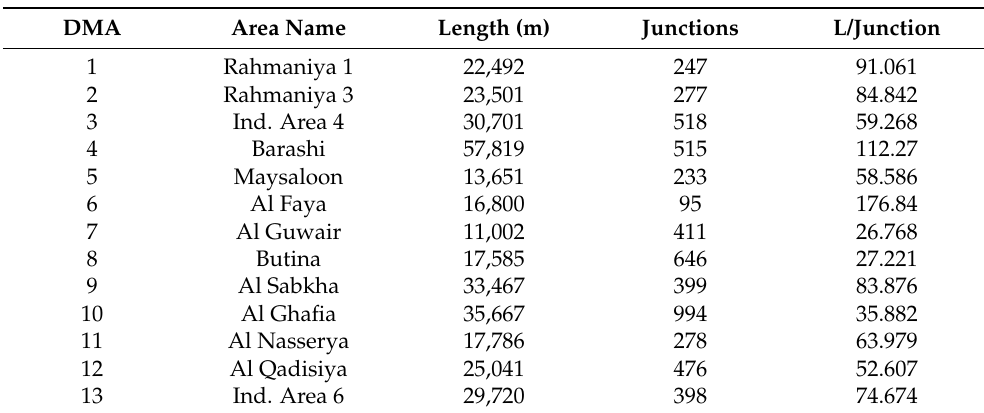
Table 3. Pipe length and